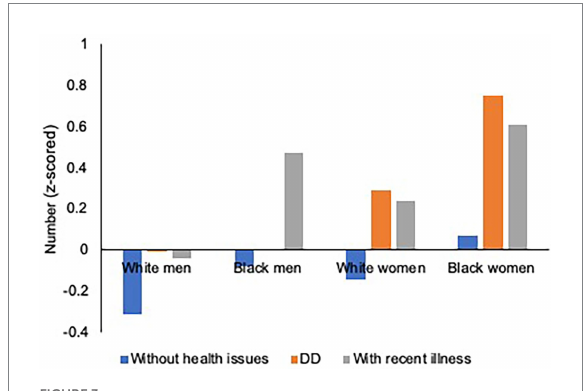
FIGURE 3 Parental Health by Race, Gender, and Parenting Type: Chronic Illnesses. Figure is based on the three-way interaction results in Table 3. Controlled for covariates and cumulative early life adversities (ELAs). DD refers to DD: Developmentally Disabled.